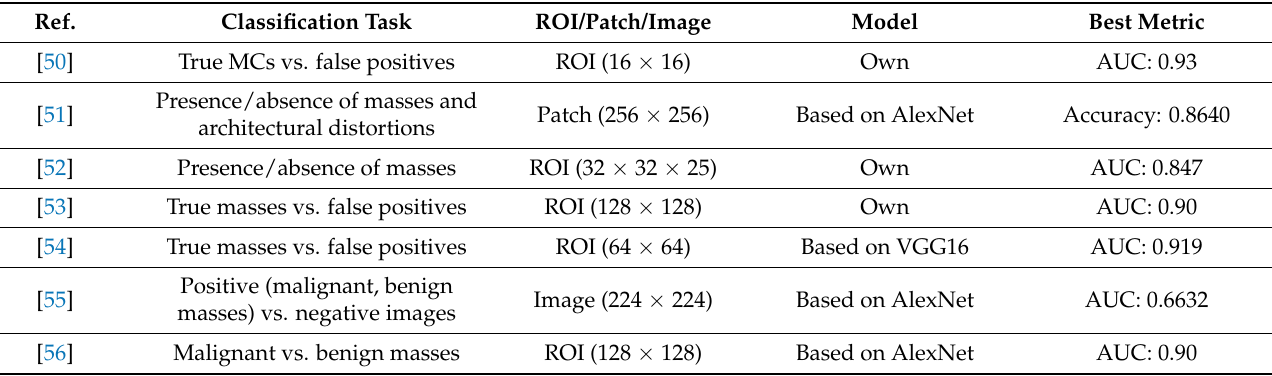
Table 1. Summary of deep learning DBT studies (ROI: region of interest, AUC: area under the curve, pAUC: partial